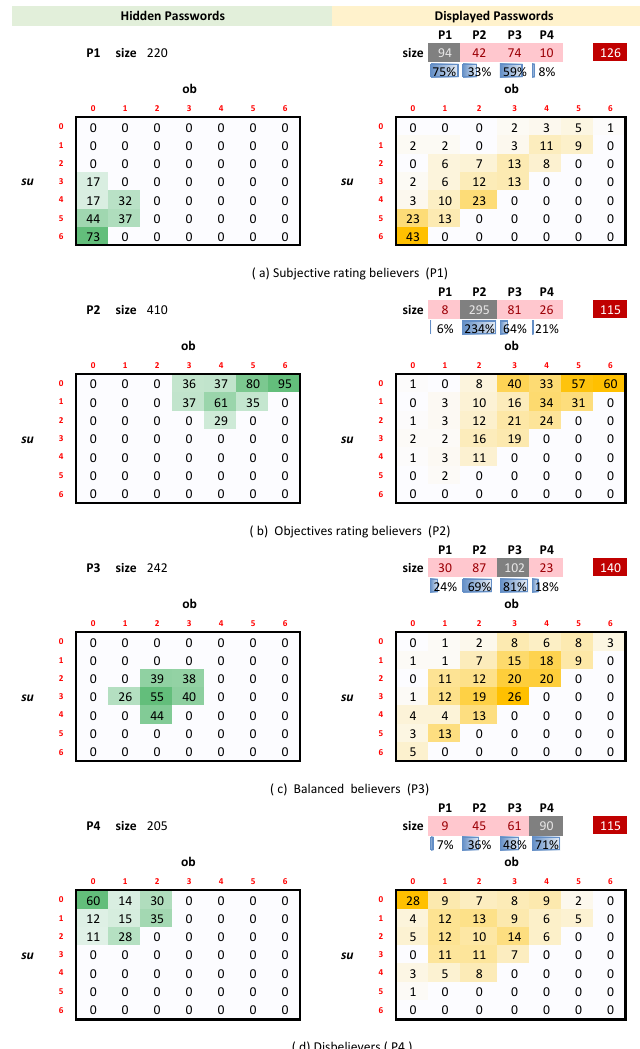
Figure 4. 2-D distribution of participants’ responses according to behavioral patterns and password display conditions.